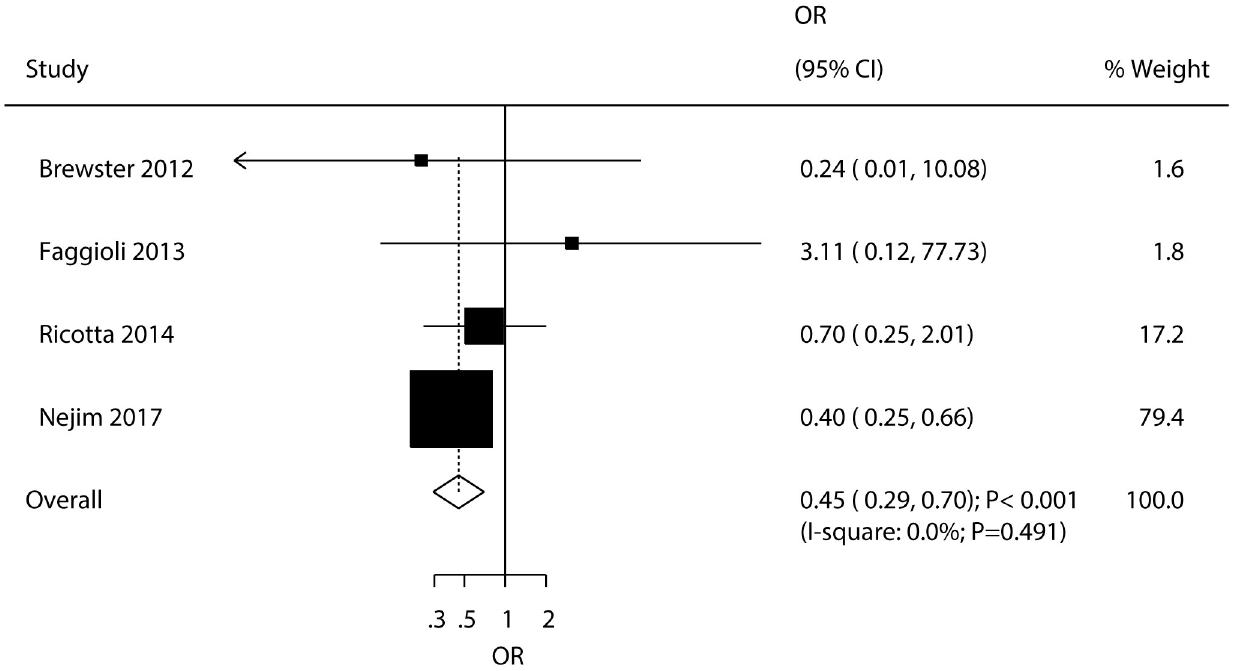
Fig 3. Effects of carotid endarterectomy (CEA) versus Carotid Artery Stenting (CAS) on the risk of